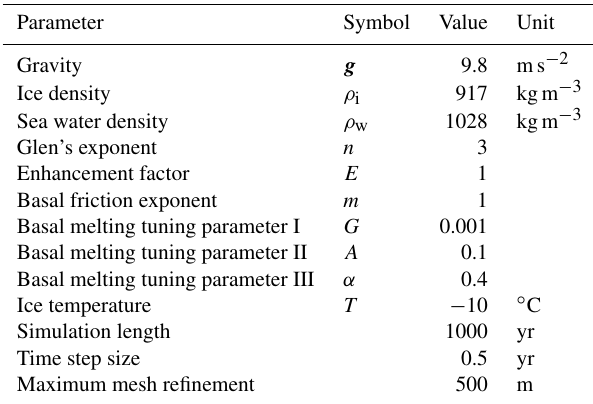
Table 1. Standard physical and numerical parameters used for the